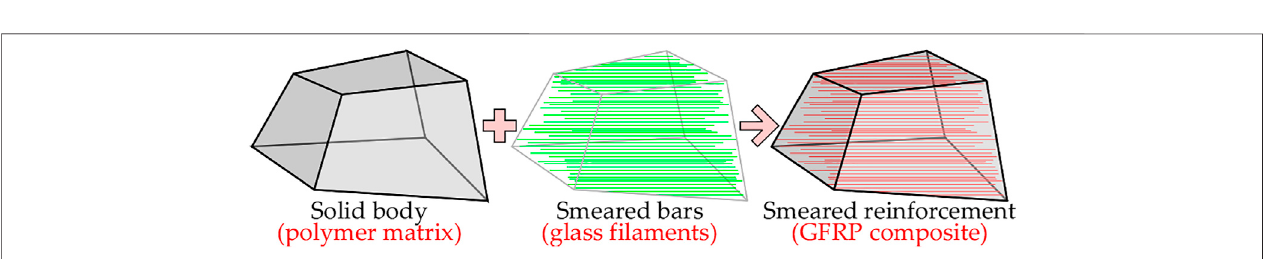
FIGURE 10 | Adapting the smeared reinforcement concept (Cervenka,